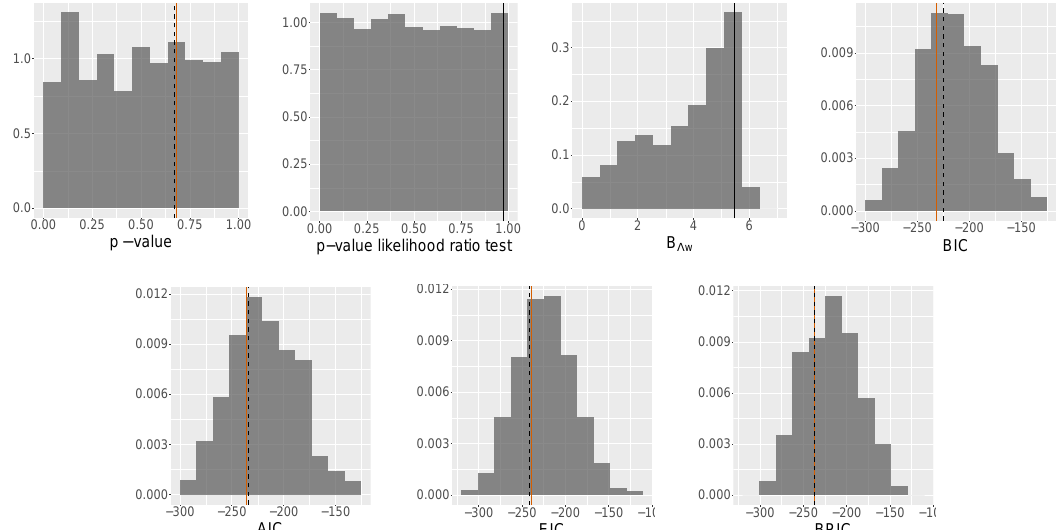
Figure 3: The normalised frequency distribution of the relevant quantities for model selection obtained from (at least) 100 Λ CDM mock samples. The vertical lines mark the values obtained from the Union 2.1 sample (compare table 1) for the Λ CDM (red) and w CDM model (dashed black). The p -value from the likelihood ratio test and the Bayes factor are already comparative quantities and only one black vertical line is